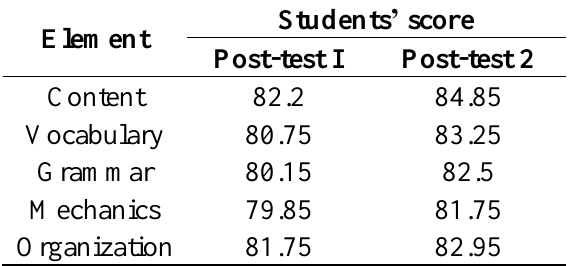
Table 5. Students’ Scores of Post Test of Cycle 1 and Post Test of Cycle